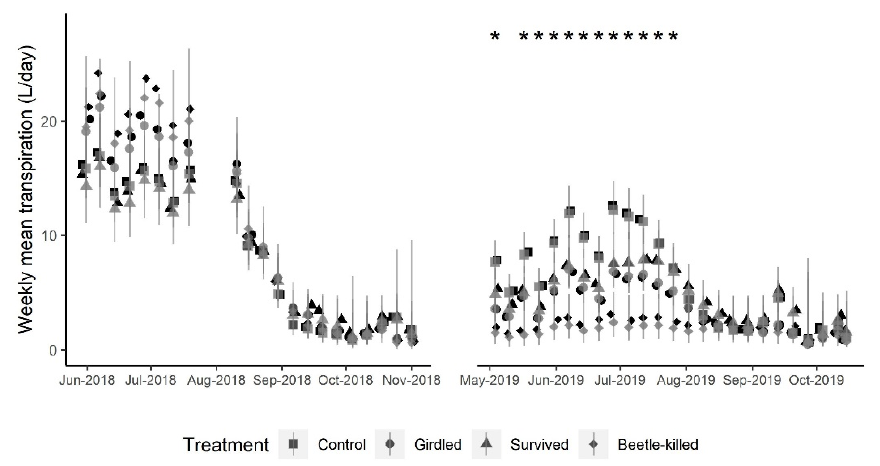
Figure 3. Estimated weekly mean transpiration rates during the 2018–19 growing seasons. Bars represent 95% confident intervals around the model estimated means (gray). Black symbols represent the observed means. Asterisks (*) indicate significant differences between treatments. A gap in late July 2018, is due to missing data. Table 1. Significant ( p -value < 0.05) pairwise differences in weekly transpiration between treatments.